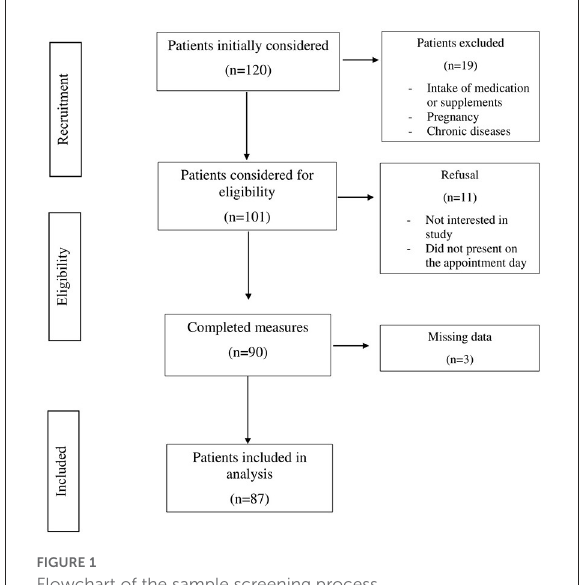
FIGURE1 Flowchart of the sample screening